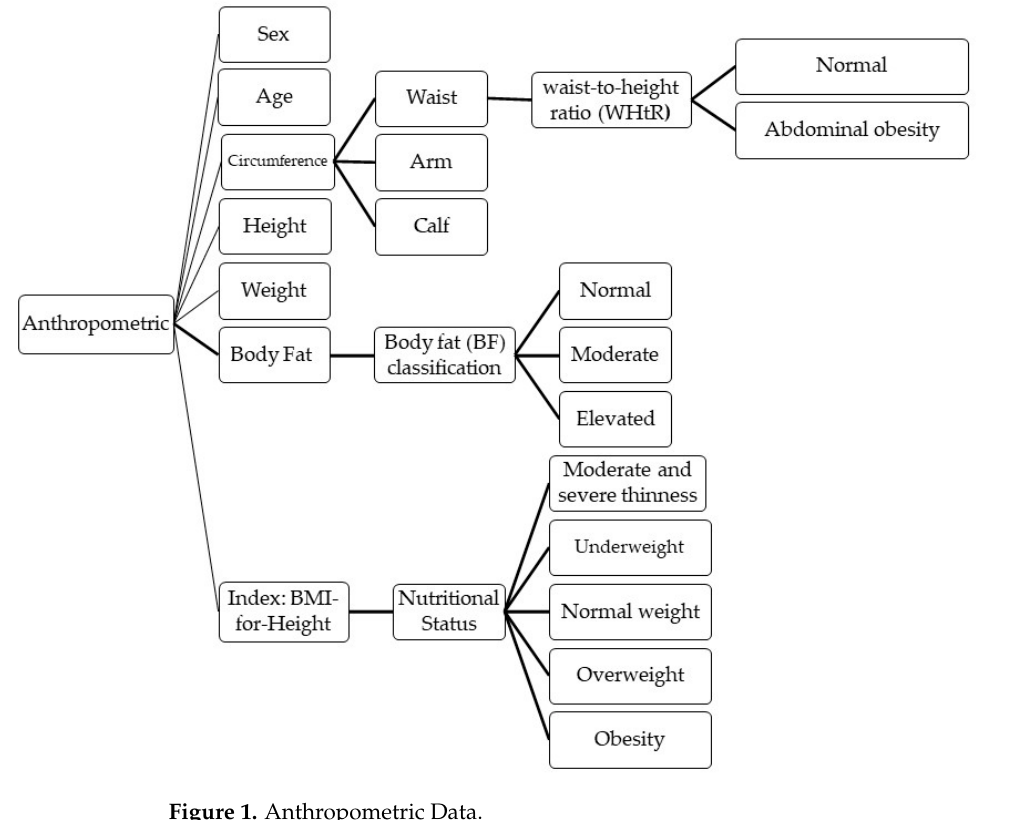
Figure 1. Anthropometric Data.